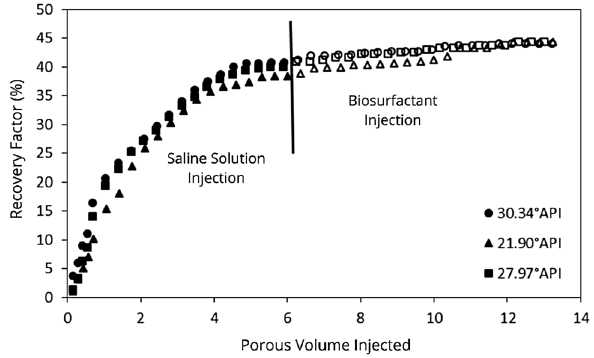
Fig. 4 Recovery factor as a function of porous volume injected for the biosurfactant solution 30% above CMC